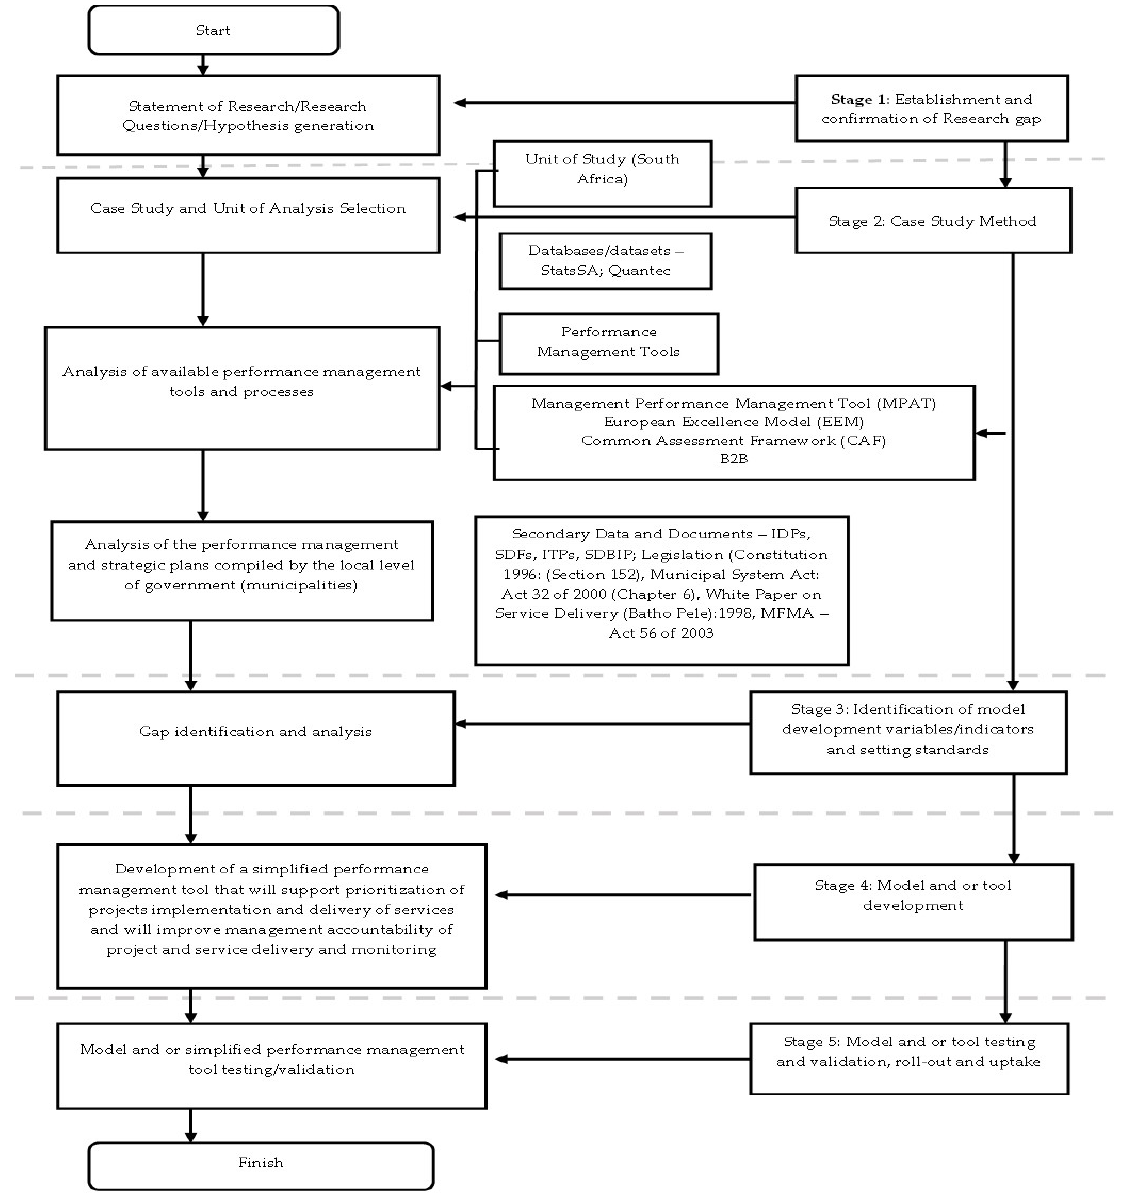
Figure 6. Study research methodology flowchart.